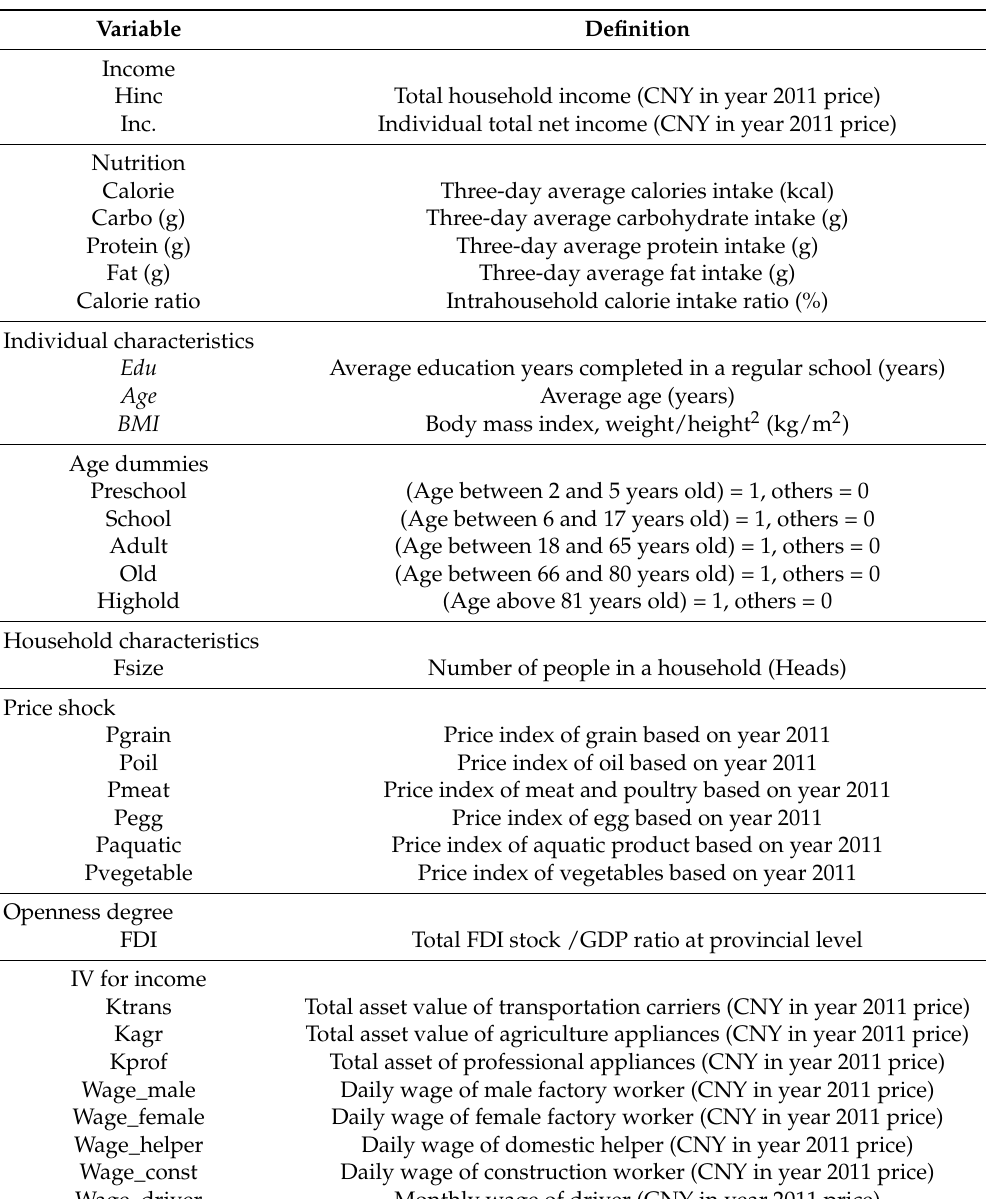
Table 1. Variables